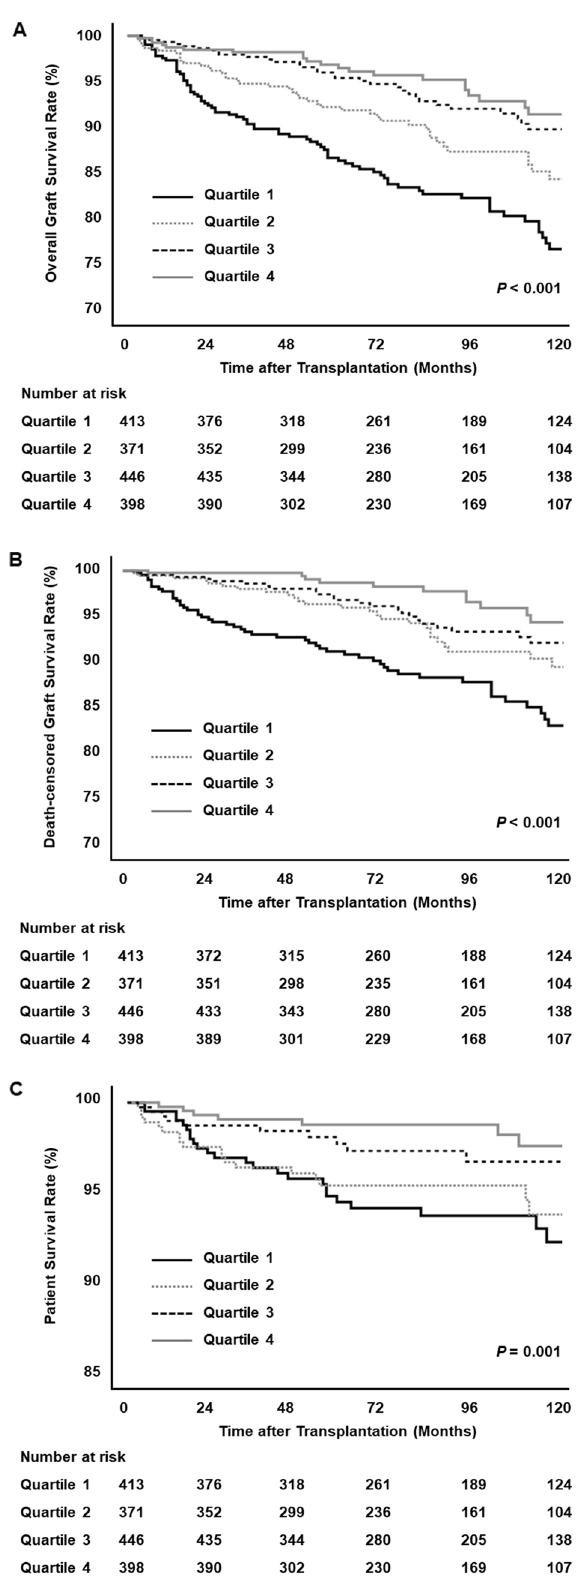
Figure 3. Graft and patient survival according to serum bilirubin level: ( A ) overall graft survival, ( B ) death- censored graft survival, and ( C ) patient